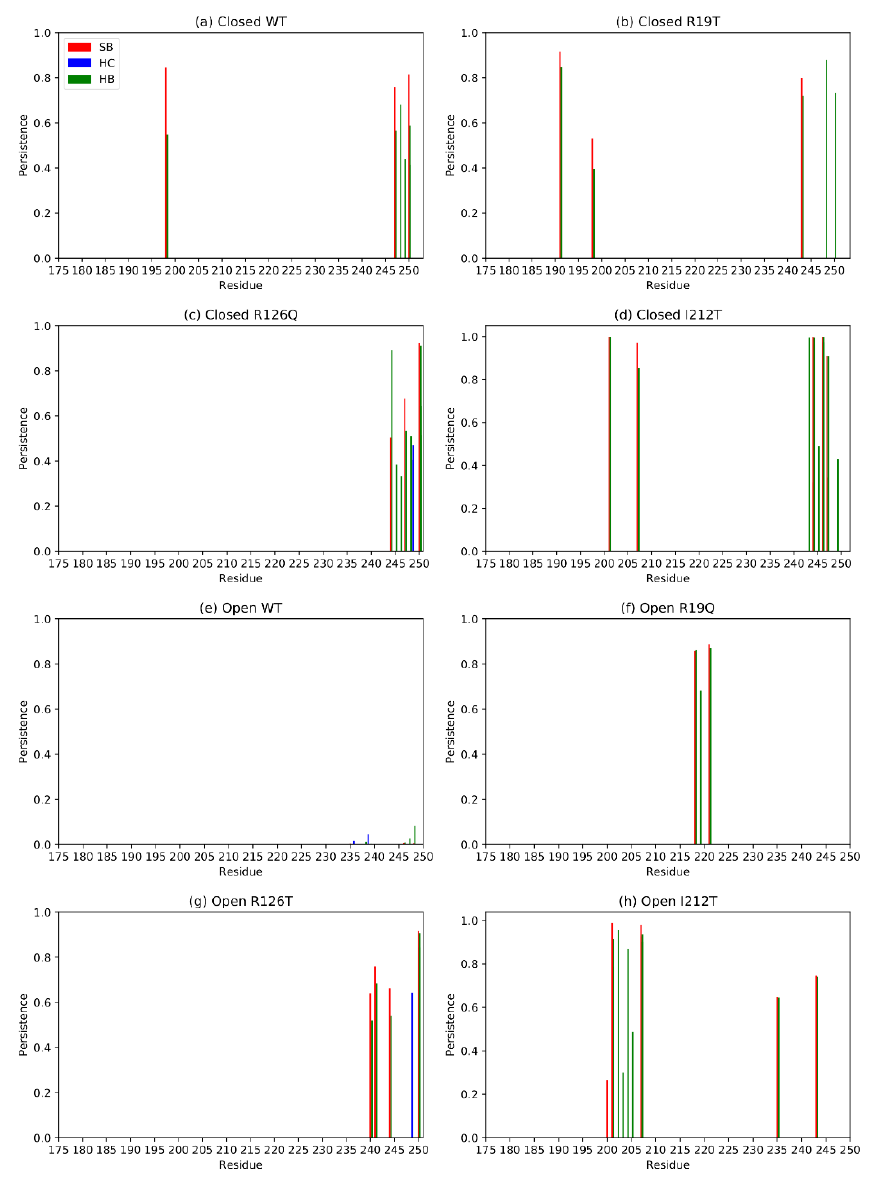
Figure 11. Principal interactions between residues belonging to domains I and III for each system. SB stands for salt bridge, HC for hydrophobic interactions and HB for hydrogen bonds.